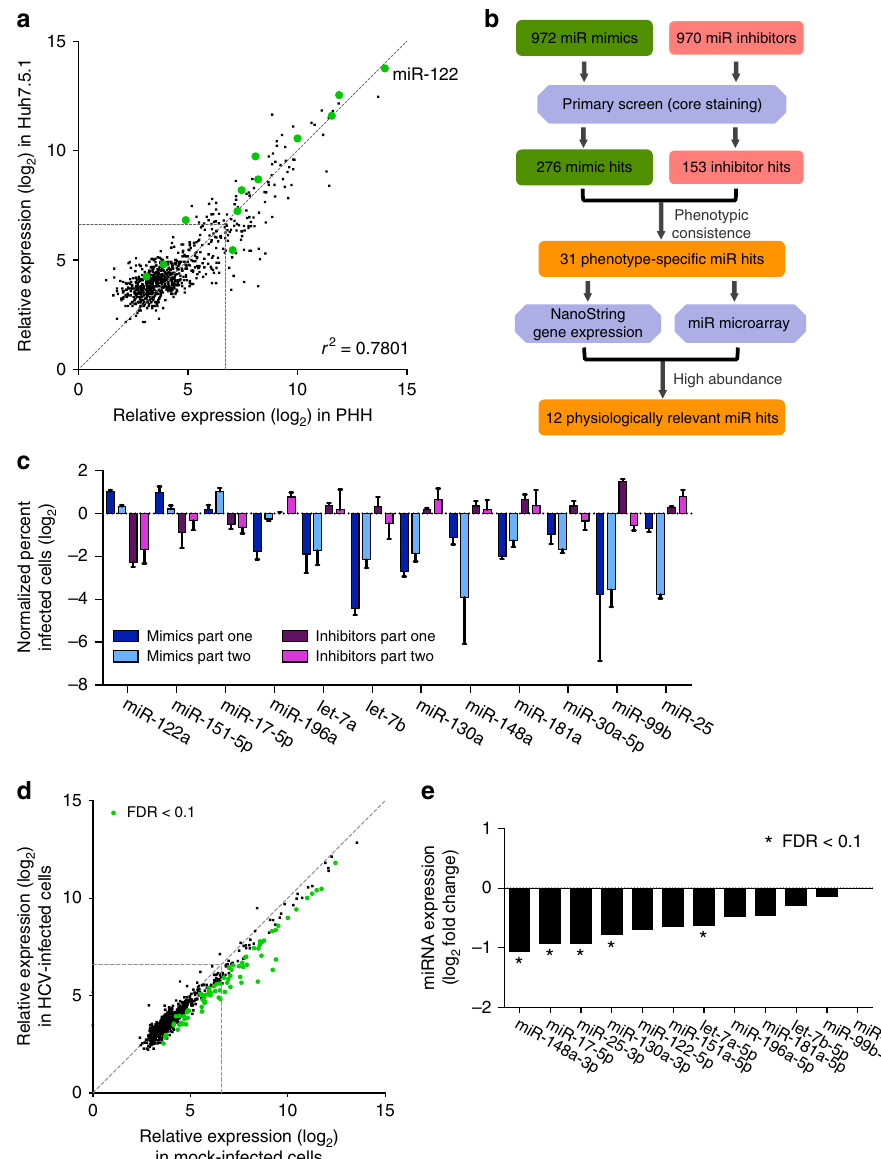
Fig. 2 HCV infection downregulates miRNA expression landscape. a miRNA transcriptome analysis using NanoString technology. Graph illustrates normalized transcript reads in Huh7.5.1 cells and primary human hepatocytes (PHH) (log 2 scale). Validated miRNA screen hits are depicted in green. X – Y dashed line represents 0.1% abundance in the nCounter assays. b Schematic diagram outlining work fl ow for identi fi cation of physiologically relevant miRNA screen hits. c Phenotypes of 12 validated miRNA hits in impacting productive HCV infection. Normalized percent-infected cells for miRNA mimics or inhibitors comparing to negative controls are shown (log 2 scale). Error bars represent SD of the mean, n = 3. d HCV infection generally reduces miRNA expression in Huh7.5.1 cells. Relative expression level of each miRNA represents average of 24, 48, and 72 h of HCV infection or mock treatment. miRNAs signi fi cantly downregulated by HCV infection (Student ’ s t -test, FDR < 0.1) are shown in green. e HCV infection downregulates the expression of biologically relevant cellular miRNAs. Graph depicts fold change comparing infected (average of 24, 48, and 72 h) and uninfected cells (log 2 scale). *FDR <